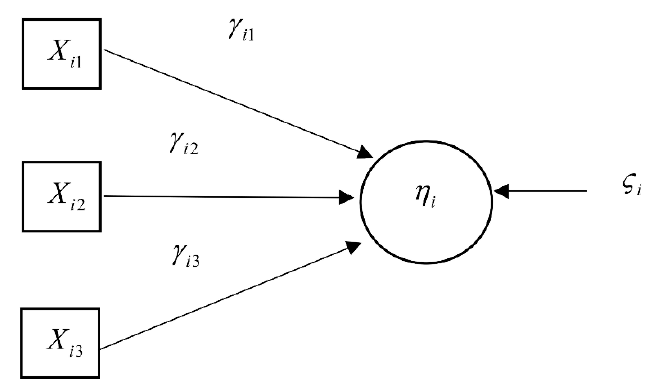
Figure 2. High level of variable correlation.